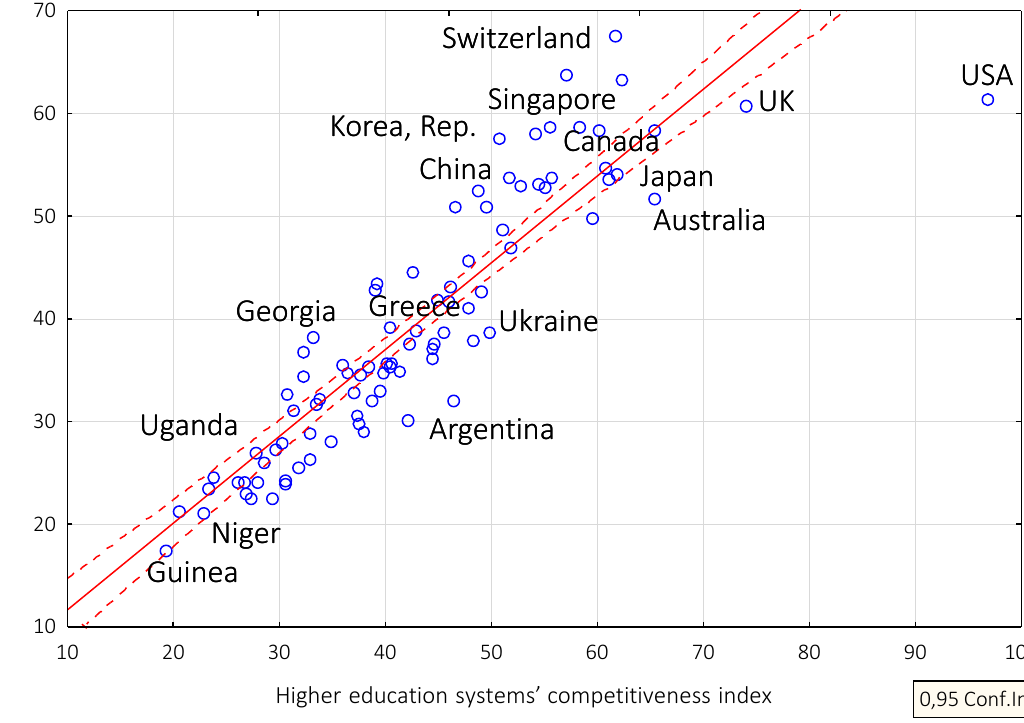
Figure 3. Scatterplot: higher education systems’ competitiveness index vs. Global Innovation Index